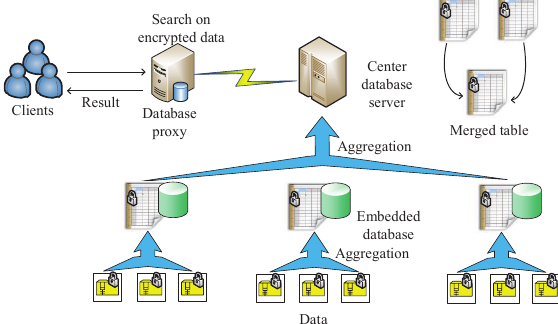
Figure 11. The architecture of the secure data management